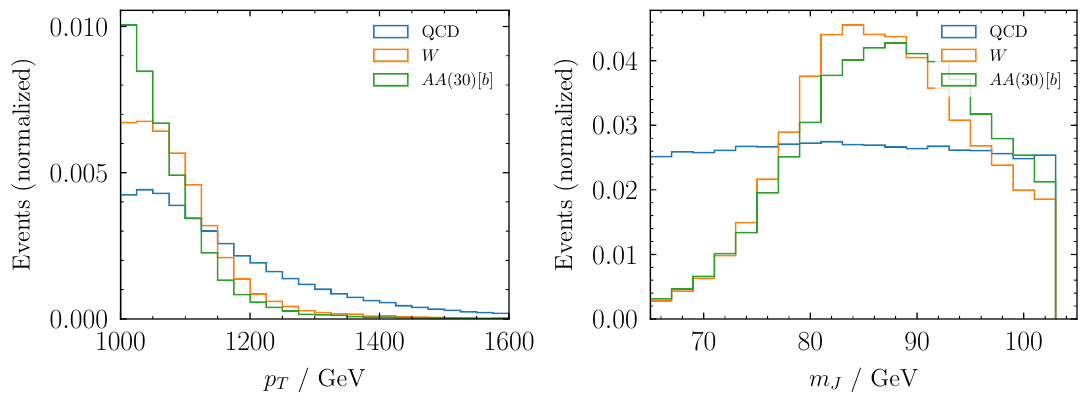
Figure 11 . Transverse momentum (left) and jet mass (right) of the QCD background and two of the signals used to test the std1000